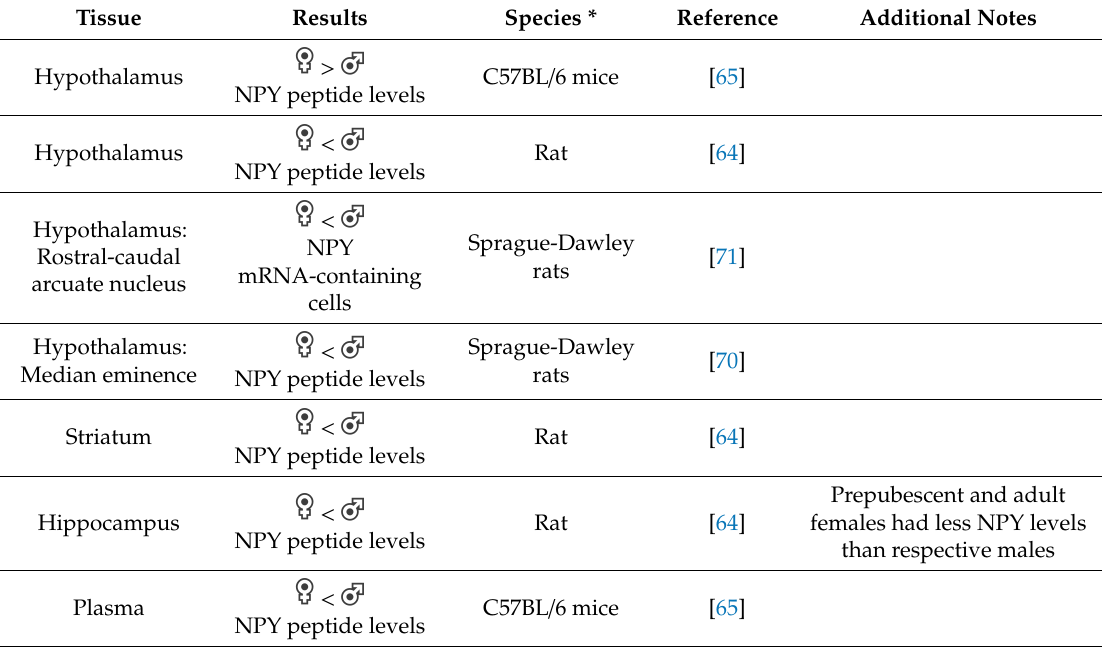
Table 1. Sex differences in NPY expression levels in unstressed conditions.